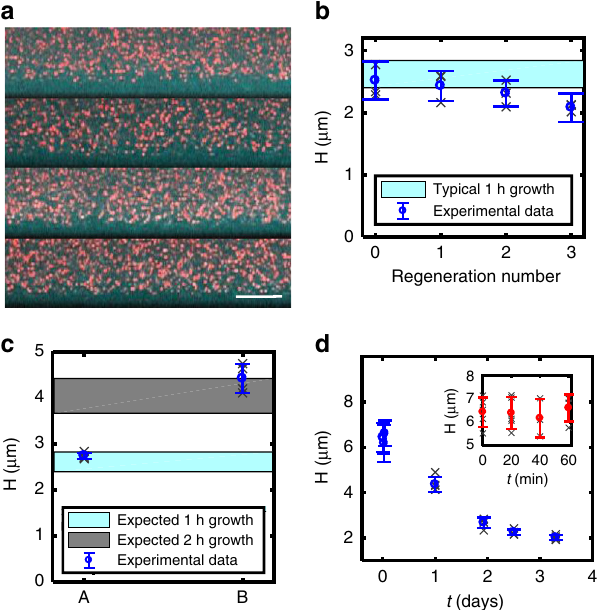
Fig. 4 Brush regeneration and patterning. a Regeneration of HA brush after enzymatic degradation with hyaluronidase. Top image shows brush after 1 h of growth before digestion. The next three images show the regenerated brush following digestion and 1 h regrowth 1, 2, and 3 times. b Brush height versus the number of regeneration times ( N = 3 brushes, where gray x ’ s correspond to average of fi ve measurements of each brush and blue is the mean and st dev). c Interrupted growth (A) followed by an additional growth period of 1 h (B). (Gray x ’ s correspond to fi ve measurements from one sample.) d Brush stability versus time (unreinforced, natural brush), For both c , d , N = 1 brush, gray x ’ s correspond to measurements on same brush, blue reports the mean and st. dev.